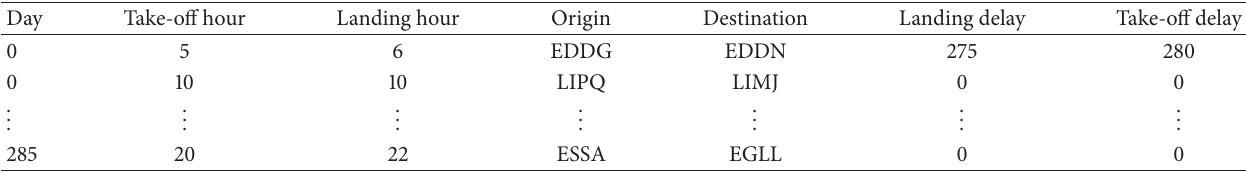
Table 1: Excerpt of the considered data set; see main text for